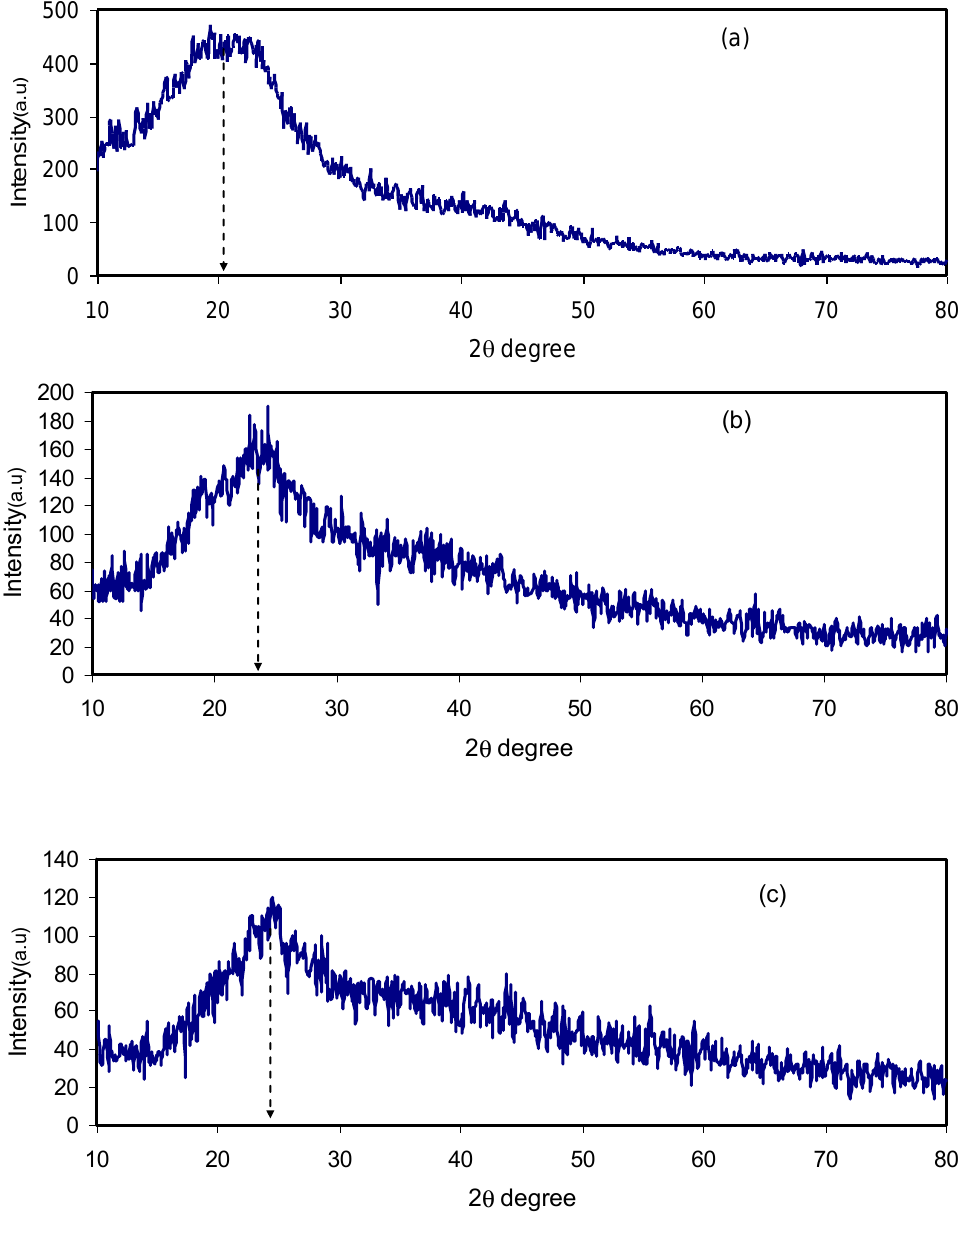
Figure 3. XRD pattern for ( a ) CSDPE0, ( b ) CSDPE2 and ( c ) CSDPE4 samples.